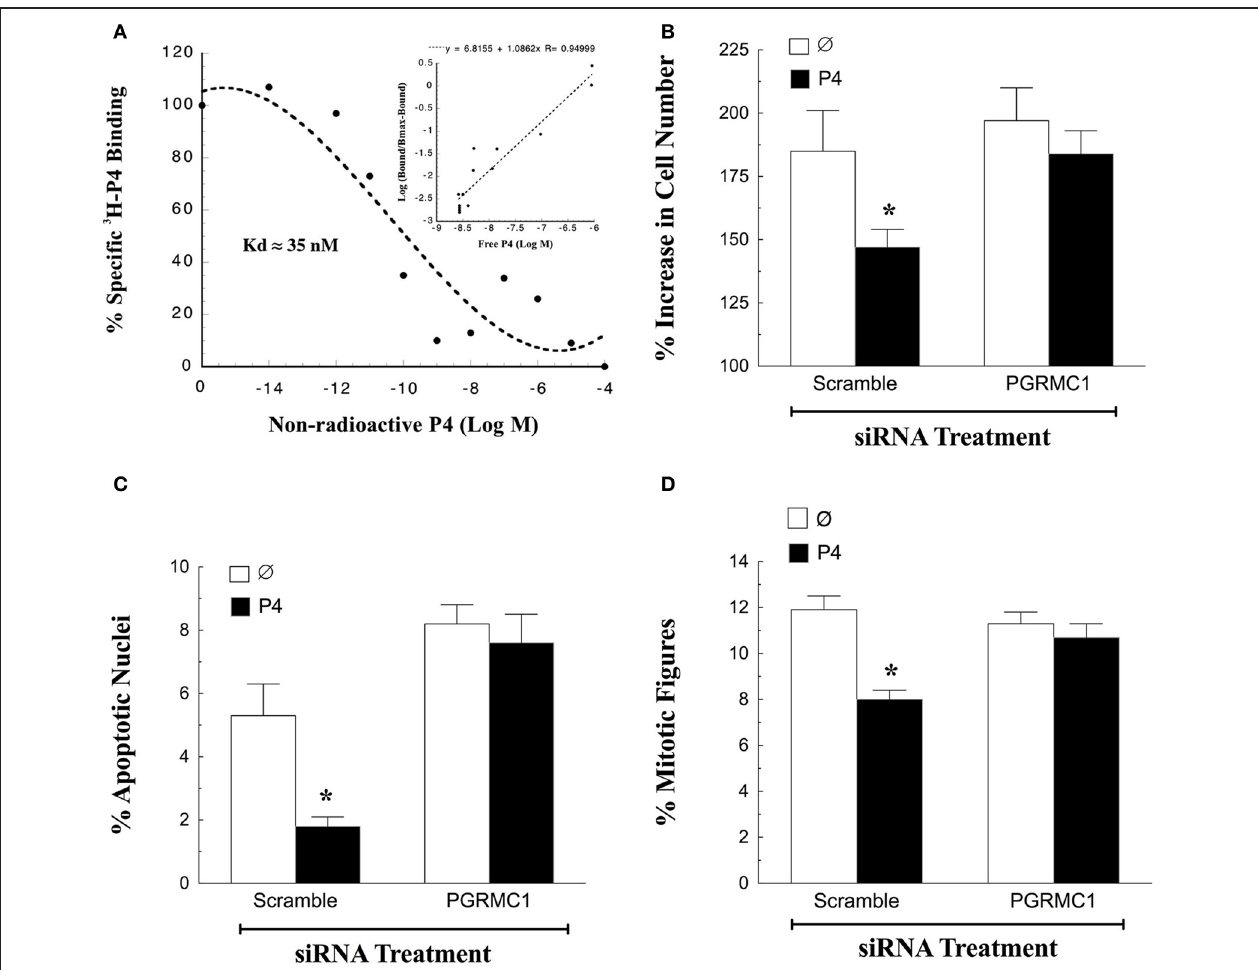
FIGURE 1 | Progesterone (P4)-PGRMC1 interactions. (A) Shows a ligand-binding analysis of 3 H-P4 to partially purified PGRMC1-GFP fusion protein. Specific 3 H-P4-binding decreased with the addition of non-radioactive P4. Hill plot analysis (inset) yielded a straight line with a slope of 1.08, indicting that 3 H-P4 specifically bound to PGRMC1-GFP in a